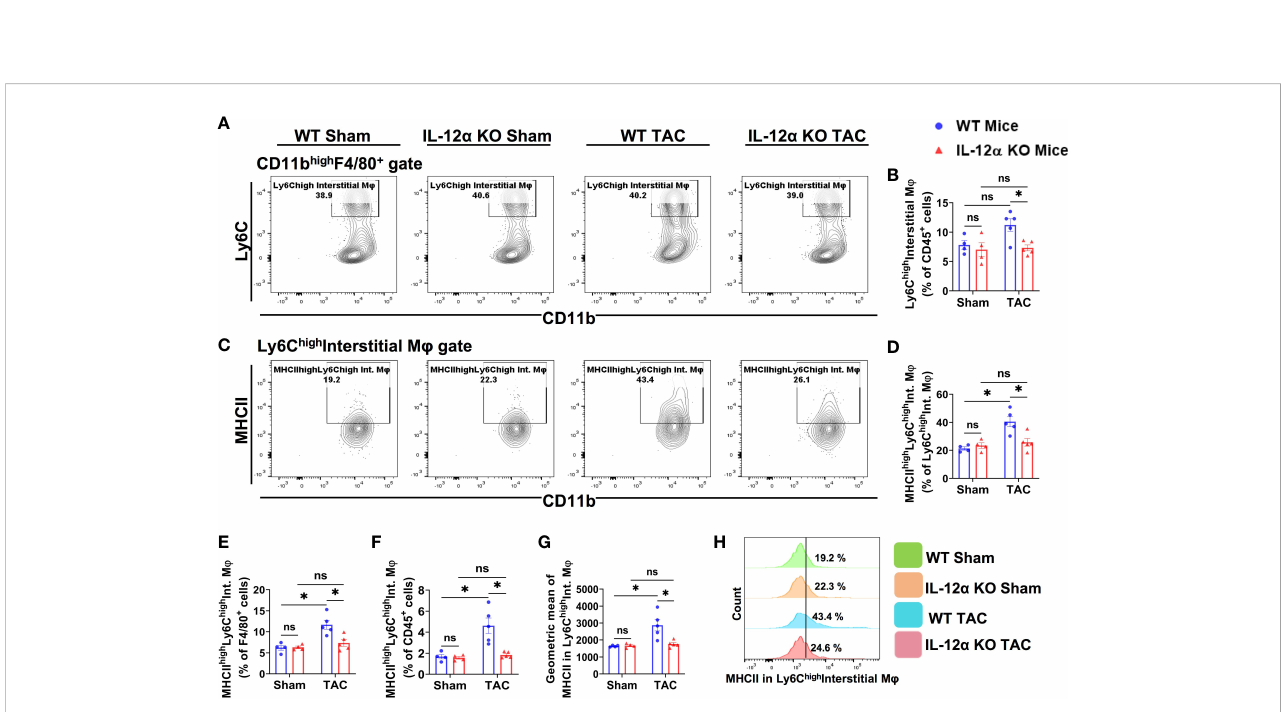
FIGURE 8 IL-12 a KO ameliorated TAC-induced activation of lung Ly6C high interstitial macrophages (Ly6C high CD11c low CD11b high F4/80 + ). (A) Representative gating plots for Ly6C high interstitial macrophages. (B) Percentages of Ly6C high interstitial macrophages within CD45 + cells. (C) Representative plots for MHCII high macrophages within Ly6C high interstitial macrophages. (D – F) Percentage of MHCII high Ly6C high interstitial macrophages within the Ly6C high interstitial macrophages, F4/80 + , and CD45 + cells, respectively. (G) Mean fl uorescent intensity of MHCII in Ly6C high interstitial macrophages. (H) Representative histogram showing MHCII expression Ly6C high interstitial macrophages. *p<0.05, ns, non-signi fi